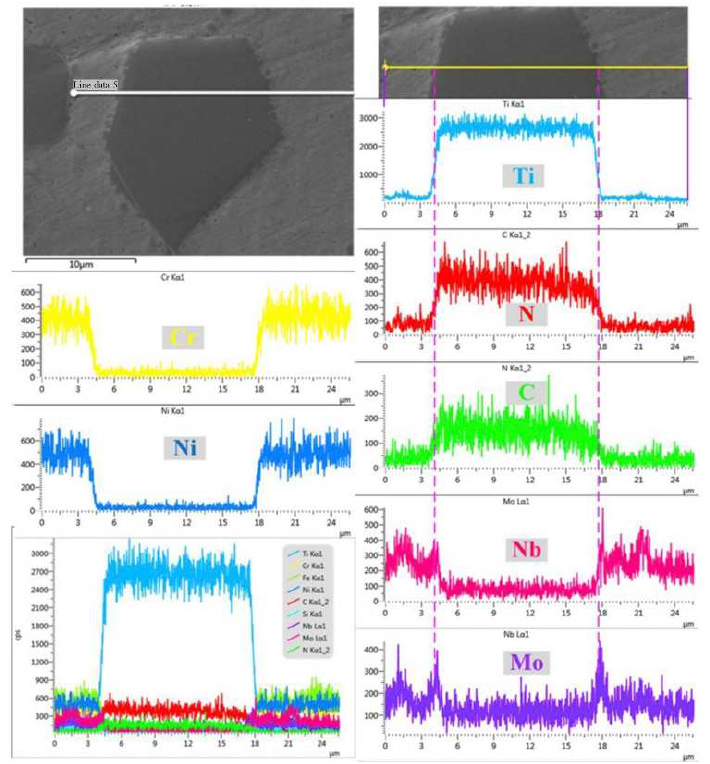
Figure 27. The EDS line scan results of the pentagonal phase (ceramic phase) in Ni204 coating (the laser power is 450 w, and the scanning speed is 330 mm/min) [132].